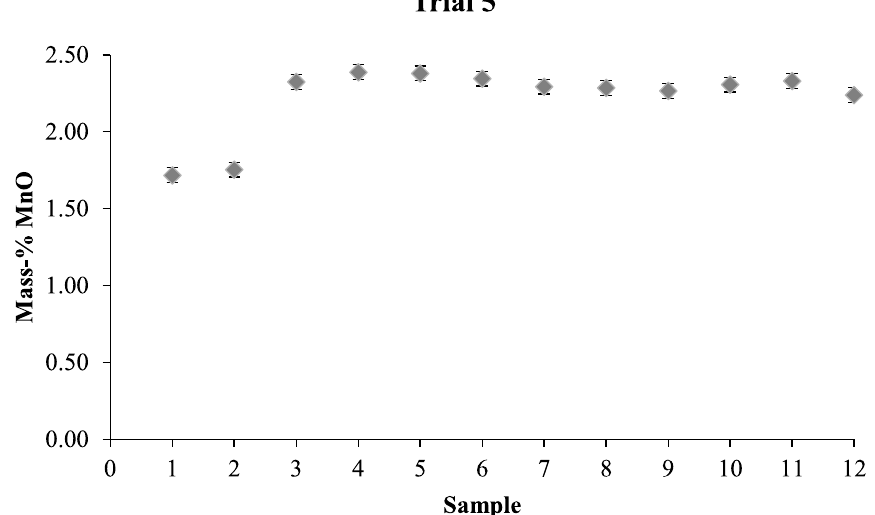
Figure 5. The amount of MnO (%) in each slag sample taken during the pilot plant experiment.